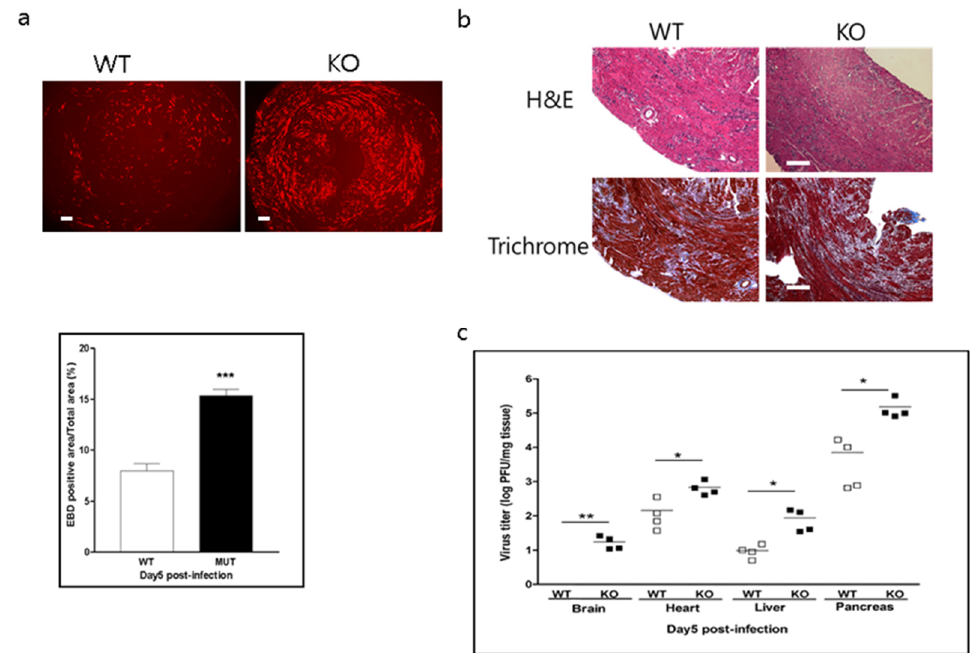
Figure 5. Effect of CAR deletion on CVB3-induced myocarditis. ( a ). Six-week-old male WT and KO mice were infected with 1 m.o.i. CVB3 for 5 days and then injected with EBD before being sacrificed. A heart section was examined by fluo- rescence microscopy. Red fluorescence represents EBD uptake by damaged myocardium (upper). The percent area of EBD was quantified with Scion Image ( n = 4 per group). ( b ). Histological findings of sectioned heart show inflammatory cell infiltration and fibrosis using hematoxylin & eosin (H&E) and trichrome staining. ( c ). Virus titers in organs of WT and KO mice determined by PFU assay ( n = 4 per group). All data are the mean ± s.e.m. from 3 independent experiments performed (scale bar, 100 µm). * p < 0.05, ** p < 0.01, and *** p < 0.001 by two-tailed Student’s t -test.